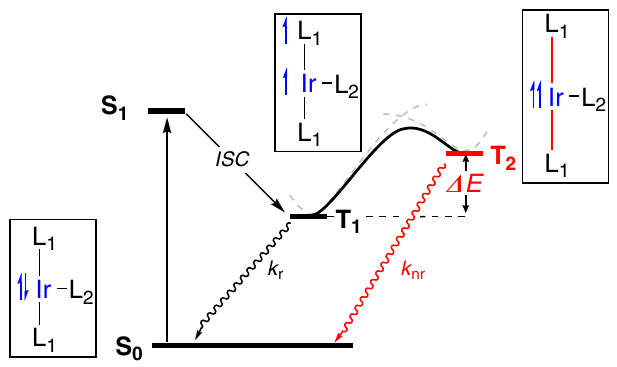
Fig. 1 Qualitative energy diagram for the heteroleptic Ir(III)-dopants. The excitation of heteroleptic Ir-dopants ( S 0 ) affords to the singlet excited state ( S 1 ) which further undergoes the intersystem crossing to the triplet state ( T 1 ). This T 1 state either emits light by phosphorescence ( k r ) or is excited to the T 2 state that is responsible for the non-radiative decay ( k nr